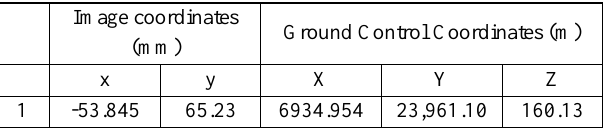
Table 2 Image points and ground control points coordinates